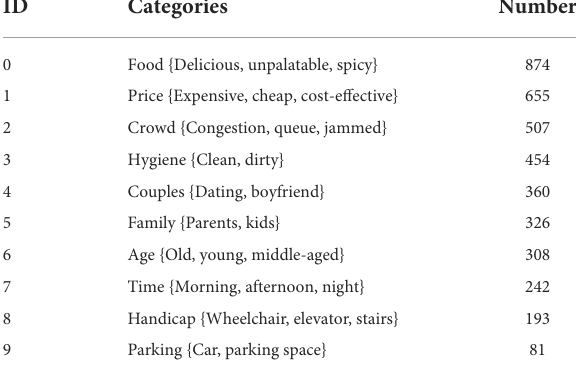
TABLE 1 Classification result.